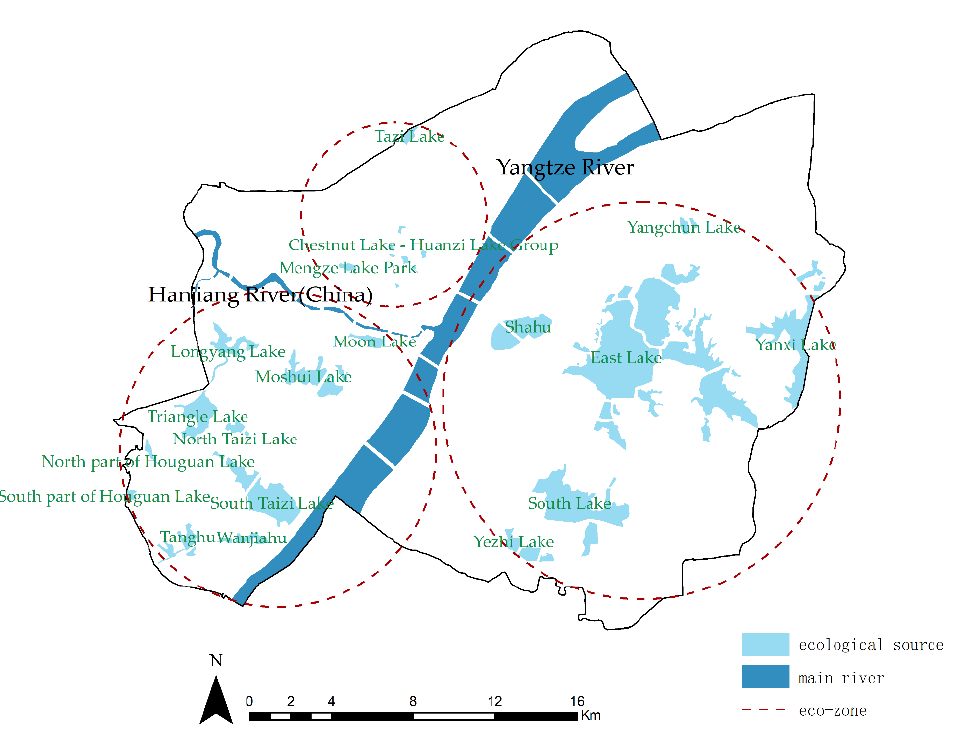
Figure 7. Distribution of ecological sources.